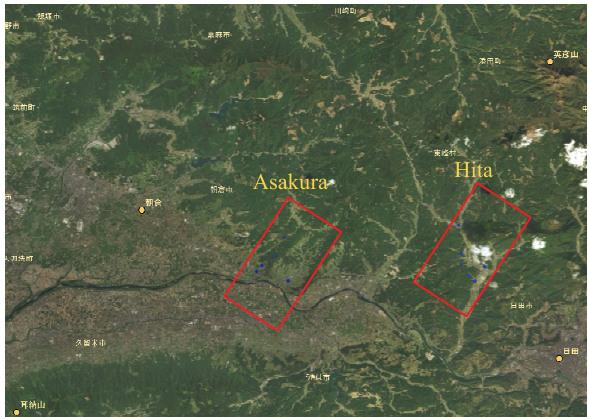
Figure 15. Site of landslide disaster.